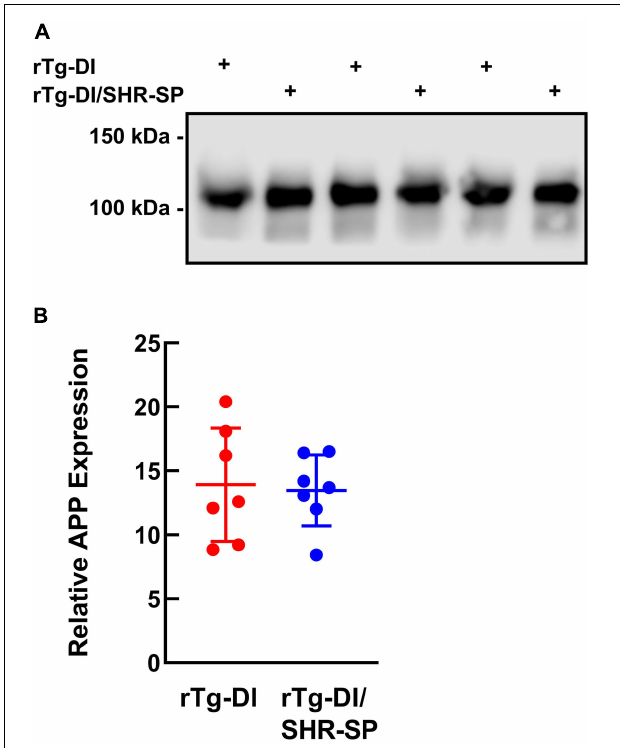
FIGURE 2 | Equivalent transgenic human A β PP expression in rTg-DI and bigenic rTg-DI/SHR-SP rats. (A) Representative immunoblots of human A β PP expression in total brain homogenates from 7M rTg-DI rats and bigenic rTg-DI/SHR-SP rats. (B) Quantitative immunoblotting was performed to measure human A β PP in brain homogenates of rTg-DI rats (red circles) and bigenic rTg-DI/SHR-SP rats (blue circles). The data presented are the means ± S.D. of n = 7 rats per each group. Unpaired t -test showed no differences in human A β PP expression in 7 M rTg-DI and bigenic rTg-DI/SHR-SP animals.